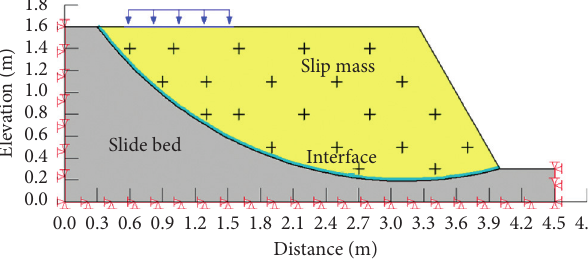
Figure 4: Numerical calculation